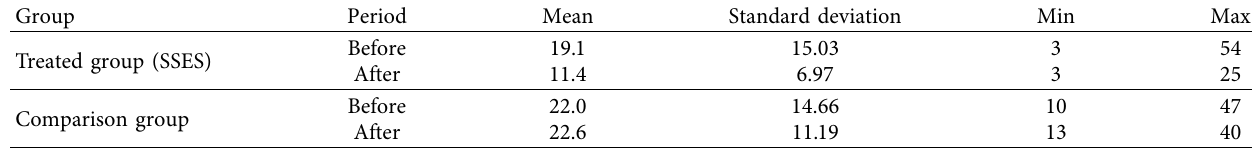
Table 2: Descriptive statistics for crashes in both the treated group and the comparison group.